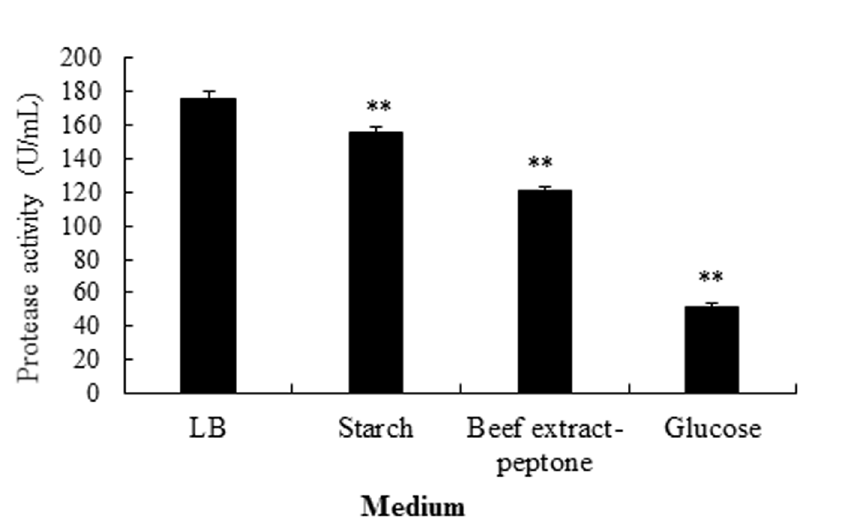
Fig 4. Effects of medium types in influencing the production of alkaline protease from strain SD8. The strain was cultured 48 h at 37°C. * P < 0.05 and ** P < 0.01 compared to LB medium. All the data were given as means ± SEM (n =